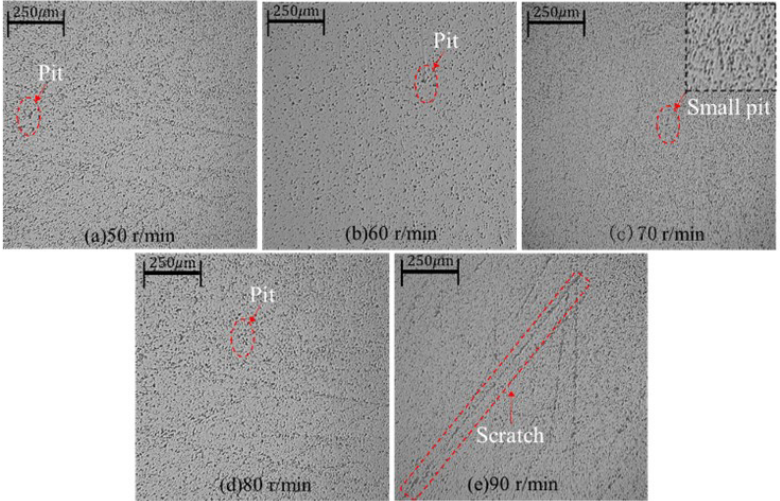
Figure 4. Microscopic appearance of samples at different rotational speeds.